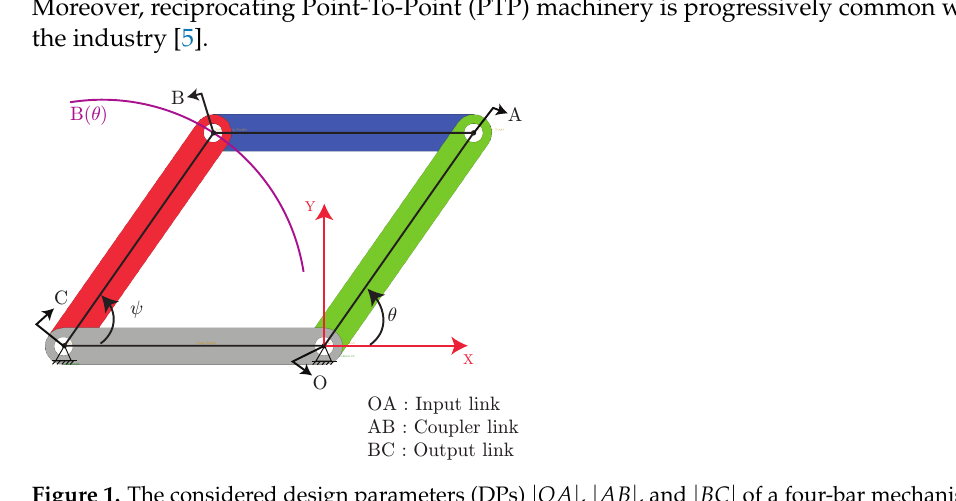
Figure 1. The considered design parameters (DPs) | OA | , | AB | , and | BC | of a four-bar mechanism, in the present paper.